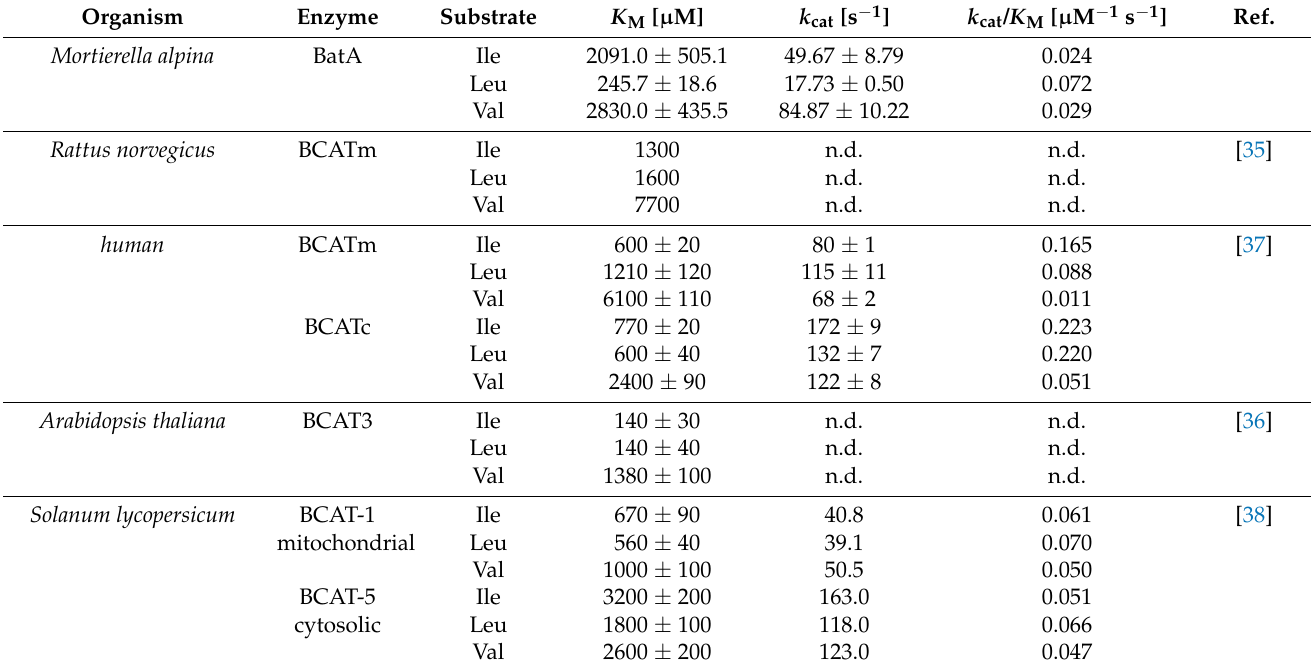
Table 2. Kinetic parameters of BatA from M. alpina and related